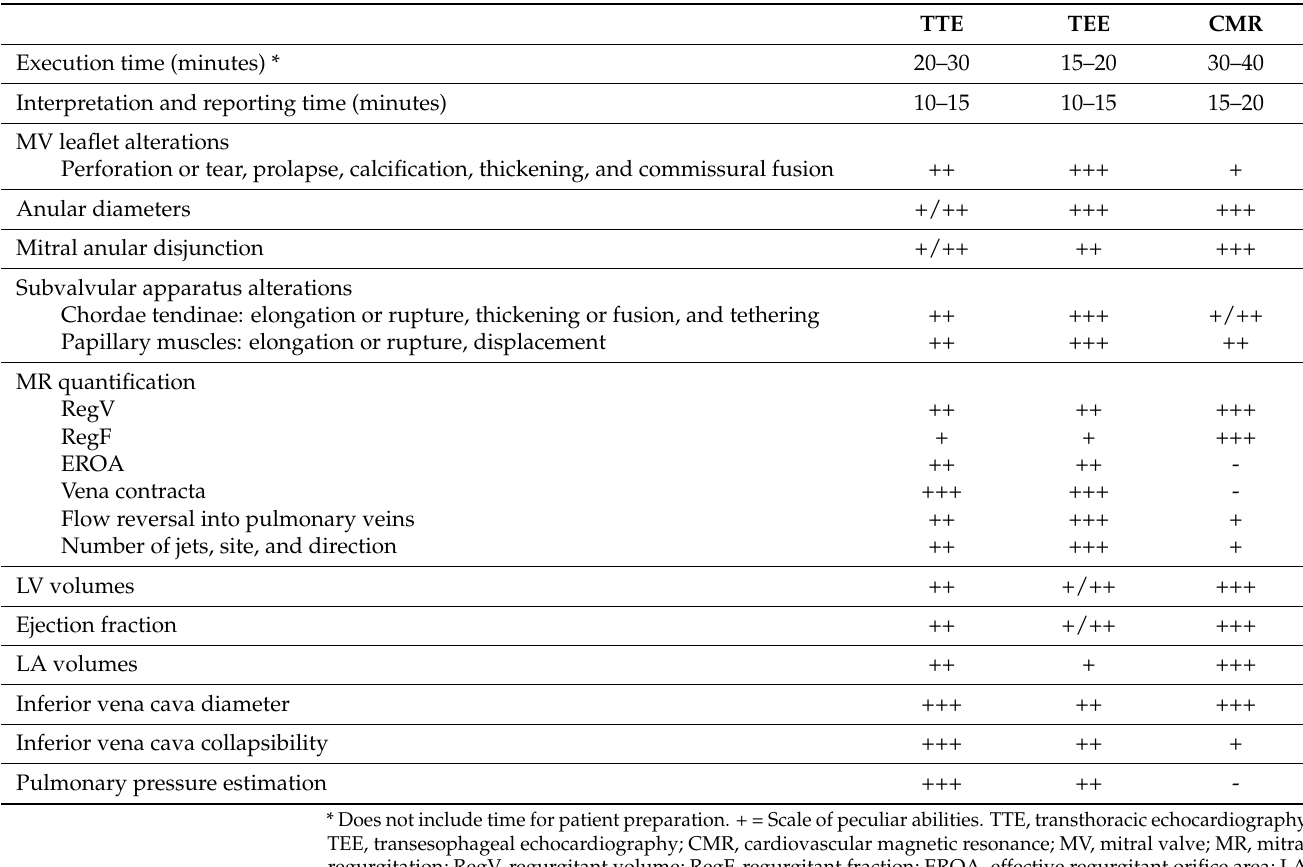
Table 1. Comparison between echocardiographic approaches and cardiovascular magnetic resonance in the assessment of mitral